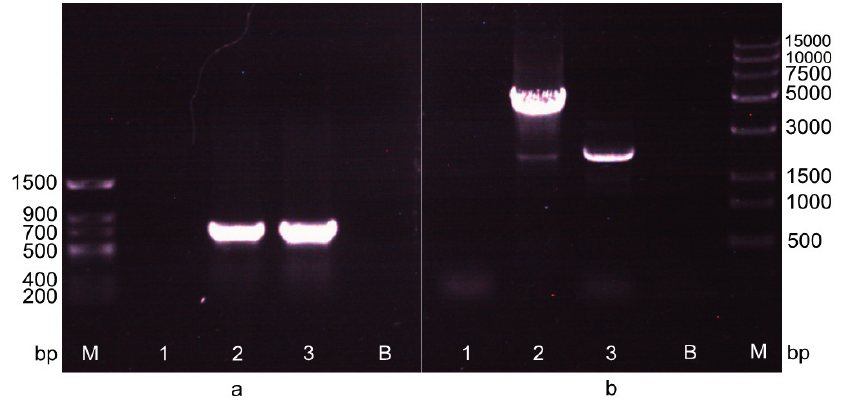
Figure 2. The detection of recombinant in the two transformations by PCR amplification. ( a ) The detection of recombinant in the first transformation by PCR amplification with primers Cm-F/R. M: Trans DNA Marker II. 1: Negative control, the PCR amplification band of Cm r gene with the genomic DNA of A. limacinum OUC88 as the template. 2: The PCR amplification band of Cm r gene with the genomic DNA of A. limacinum OUC_CG as the template. 3: Positive control, the PCR amplification band of Cm r gene with the plasmid pACYCDuet-1 as the template. B: Blank control; ( b ) The detection of recombinant in the second transformation by PCR amplification with primers 18S+-F/P pgk -R. M: Trans 15K DNA Marker. 1: The PCR amplification band with genomic DNA of A. limacinum OUC88 as the template; 2: The PCR amplification band (3655 bp) of 18S+- lox P- Cm r - lox P-P pgk with genomic DNA of A. limacinum OUC_CG as the template; 3: The PCR amplification band (2185 bp) of 18S+- lox P- lox P-P pgk with genomic DNA of A. limacinum OUC_EG as the template; B: Blank control.